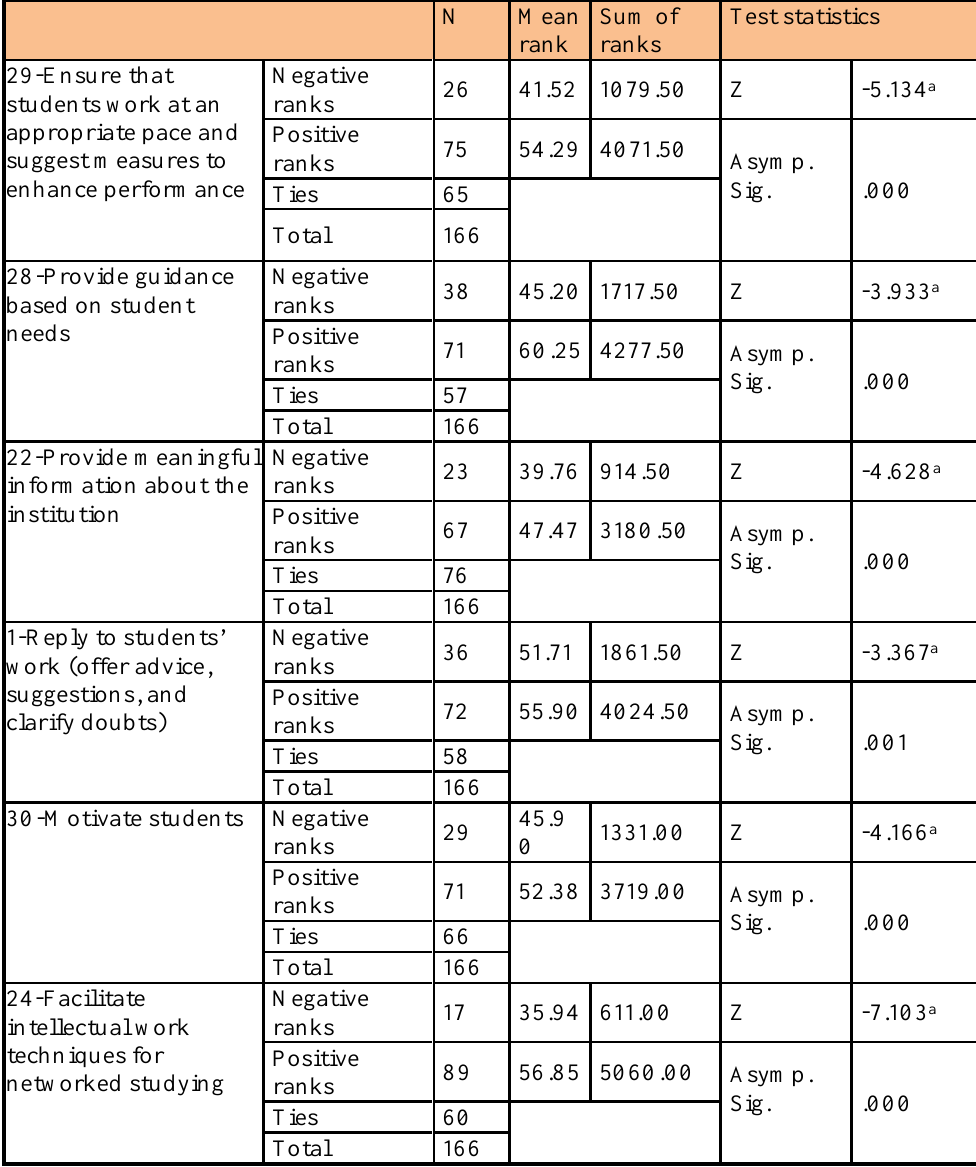
Wilcoxon Signed Ranks Test. Median Difference on the Level Of Proficiency and Professional Development Needs Regarding the Advisor Role Competencies Applied to Online